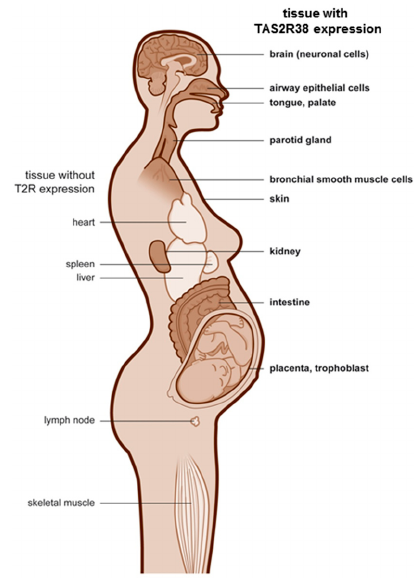
Figure 4. TAS2R38 expressing human tissues. The cartoon highlights organs that express TAS2R38 in the human organism in bold on the right site, and organs that are negative for TAS2R38 on the left site.